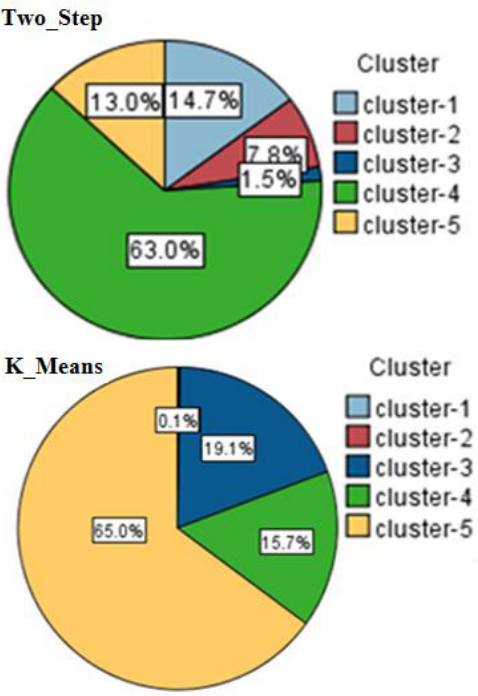
Figure 5: Two_Step and K_Means with 5 clusters.